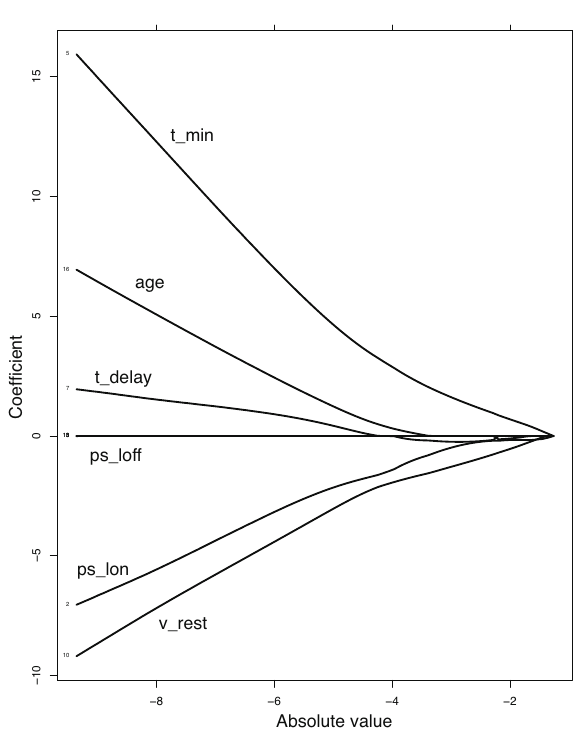
Figure 6. Change in λ coefficients (b10 condition)